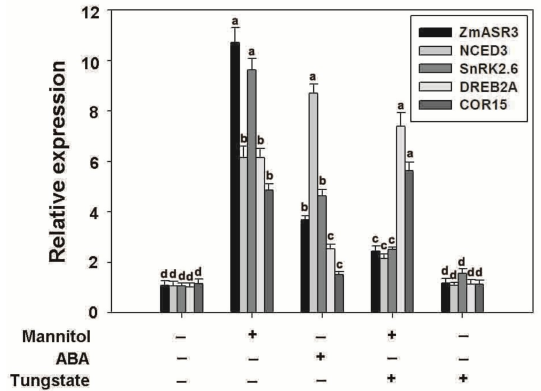
Figure 11. E ff ects of Tu and mannitol on the expression of stress / ABA-related genes in ZmASR3 -overexpressing transgenic lines and WT. Marker genes in the ABA-dependent pathway ( NCED3 and SnRK2.6 ) and ABA-independent pathway ( COR15 and DREB2A ) were analyzed in ZmASR3 -overexpressing lines under di ff erent treatments. Vertical bars indicate means ± S.E. ( n ≥ 3). ANOVA was used to reveal significant di ff erences. Di ff erent letters above the column indicate statistical significance at the p = 0.05 level. + presents “treatment”, − presents “no